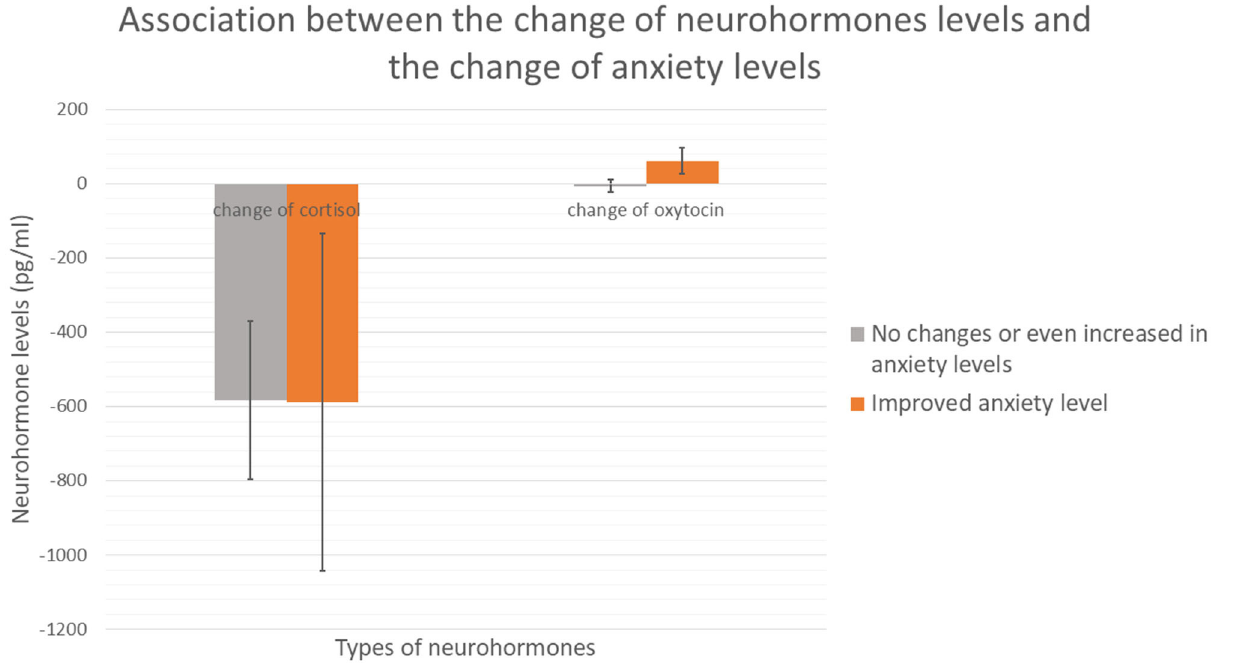
FIGURE 2 | Association between the change of neurohormones and the change of anxiety